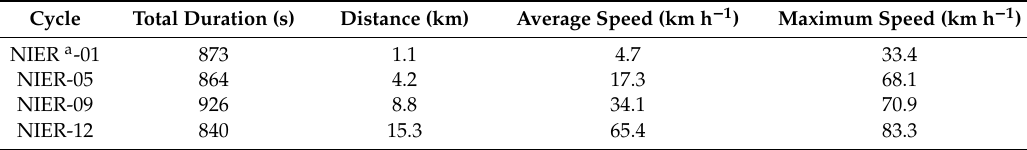
Table 3. Specifications of test cycles considered in this study.